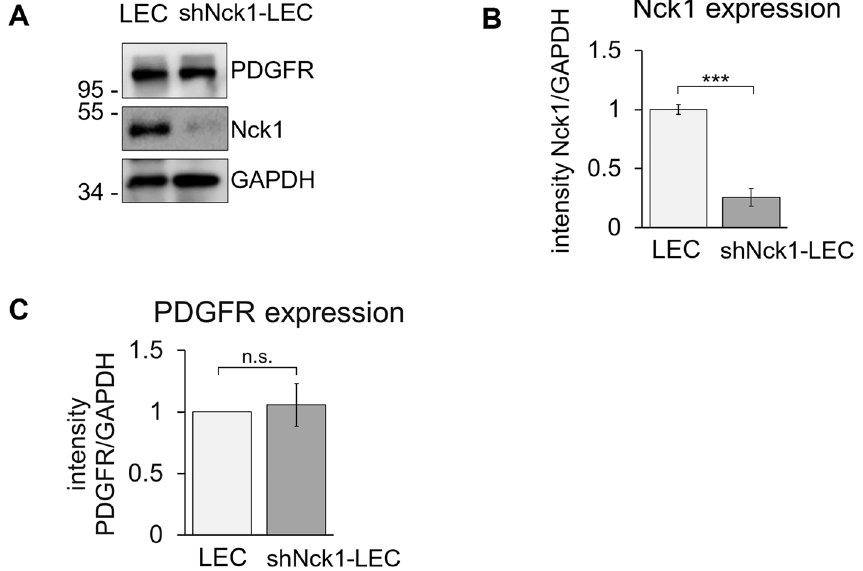
Figure 1. Expression of Nck1 adaptor protein was reduced after transfection with Nck1- shRNA expression vector. ( A ) LEC were transfected with a Nck1-specific shRNA expression vector. Following 48 h of transfection, a stable clone of Nck1 knockdown LEC was selected in medium containing 4 µg/ml puromycin. Cell extracts were subjected to western blot analysis probing with anti-Nck1, anti-PDGFR and anti-GAPDH antibodies. ( B ) Values in ( A ), quantification of signal intensity, presented as the ratio of Nck1 or PDGFR to corresponding GAPDH in relative to the protein of choices expressed in control LEC. A clone with a similar level of PDGFR expression were selected for further studies. Data are representative of three experiments (mean ± SEM). n.s. = not significant, ***p <